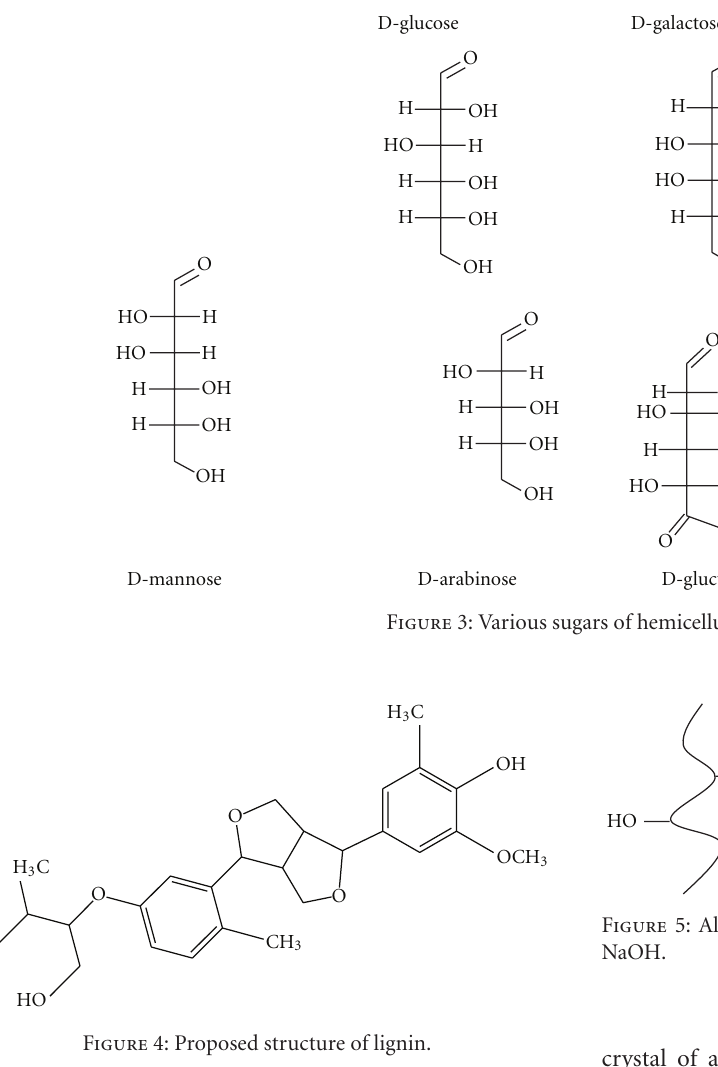
Figure 4: Proposed structure of lignin.